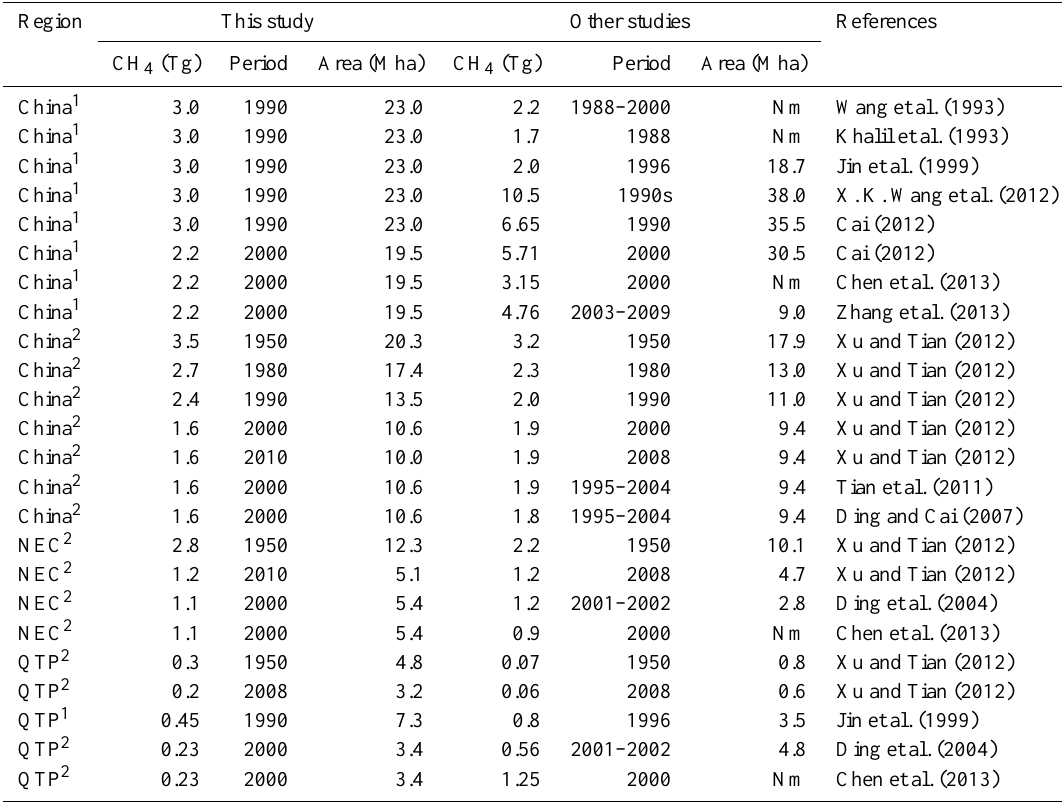
Table 3. Estimation of CH 4 emissions from natural wetland in China.